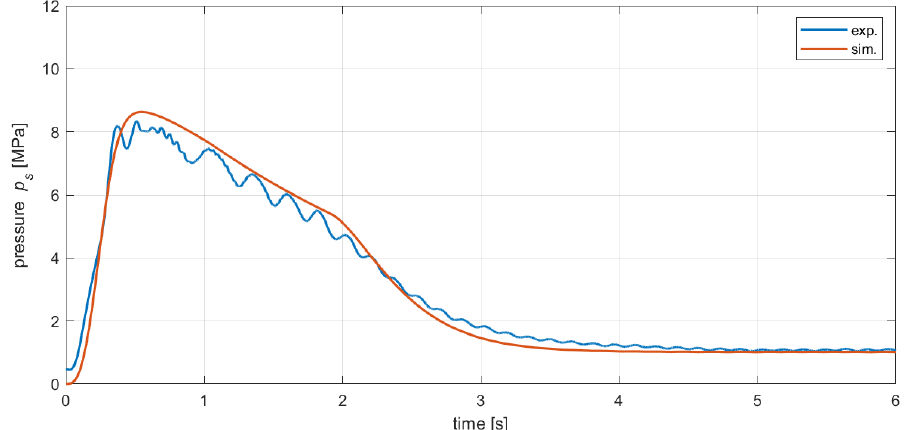
Figure 13. The hydrostatic transmission test stand: 1—planetary gear; 2—coupling housing; 3—hy- draulic gear motor; 4—hydraulic power source.